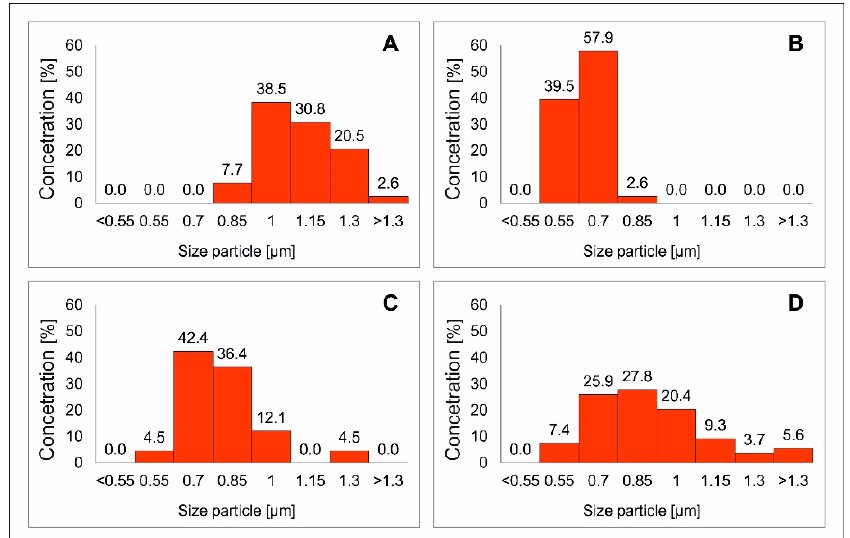
Figure 6. Statistical particle size distribution diagrams Cu 2 FeSnS 4 (CFTS) resulting from different synthesis times: ( A ) 1 day, ( B ) 3 days, ( C ) 1 week, ( D ) 2 weeks. The extended synthesis time generates larger microparticles and the optimal reaction time is one week.